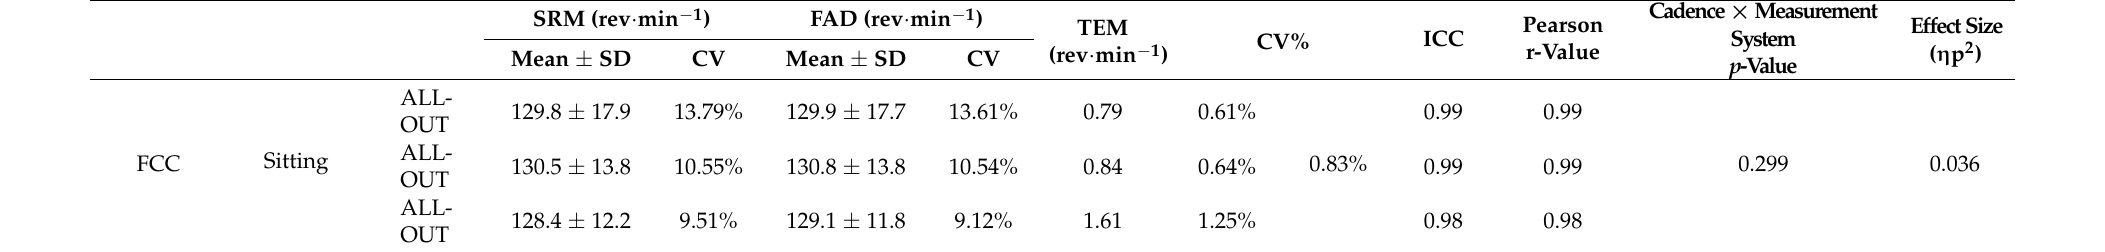
Table 4. Analysis of the peak cadence registered by the SRM and the FAD power meters during all-out